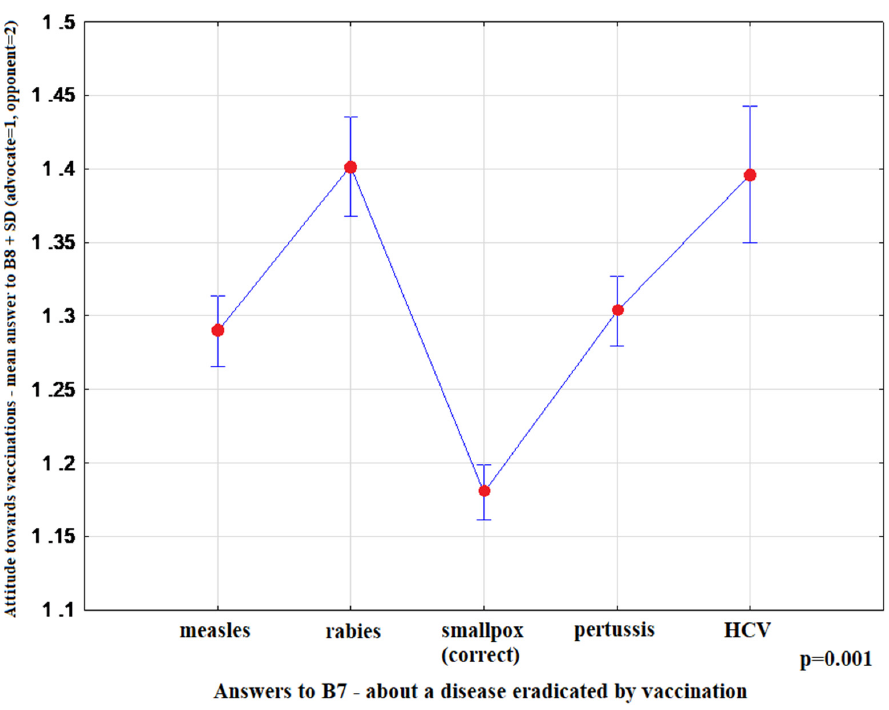
Figure 4. OY axis: Mean rank ‐ answer to the question about the attitude toward vaccination (B8) + SD (advocate = 1; opponent = 2) OX axis: Answers to B7 ‐ about a disease eradicated by vaccination (measles n = 1358; rabies n = 695; smallpox ‐ correct n = 2199; pertussis n = 1373; HCV (Hepatitis C Virus) n = 358).